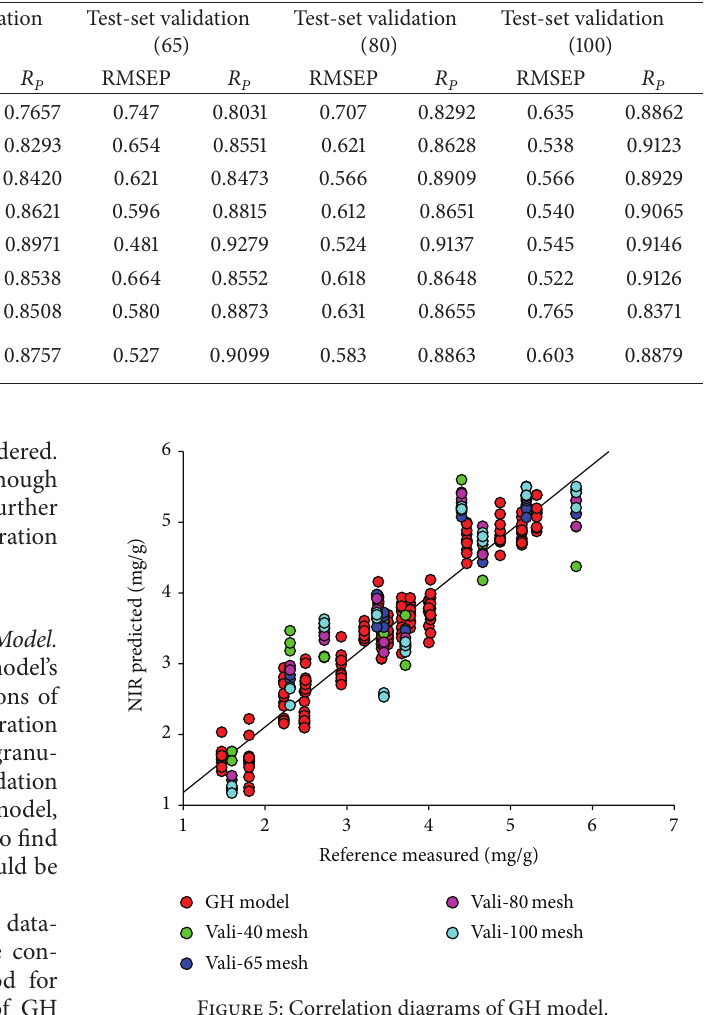
Table 5: Prediction performance of GH model.